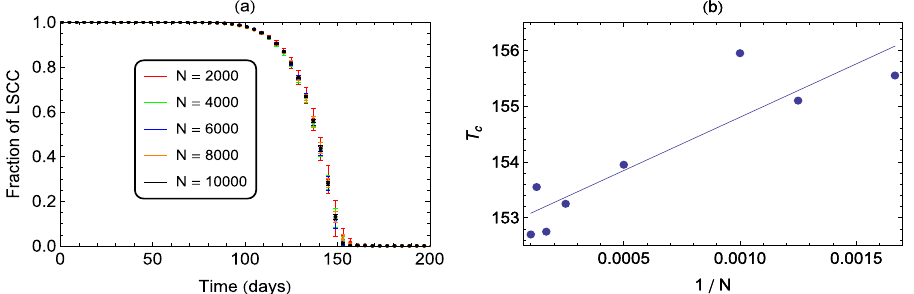
Figure 3. ( a ) Decrease in fractional size of LSCC as a function of loss of spines is studied for different values of network size N . We observe that the critical time at which the networks breakdown appears to converge to a critical time T c as N increases. ( a ) Scaling in the behaviour of LSCC with N near the transition obtained by plotting T c values against (1/ N ). The intercept on the y-axis gives the value of T c in the large size limit as ≈ 150 days and the slope gives the value of scaling index β as 1.0. The results shown for networks of size N = 10 4 and link density of 10 are averaged over 100 realizations.